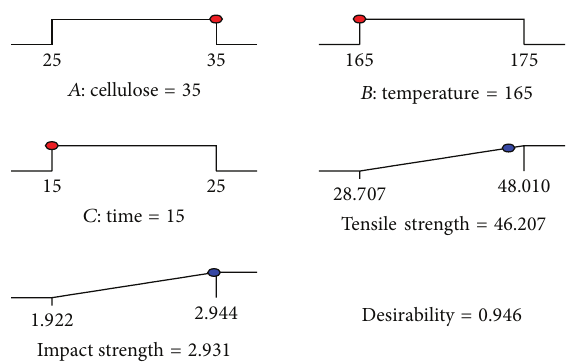
Figure 6: Optimum condition of the independent variables and the responses of the